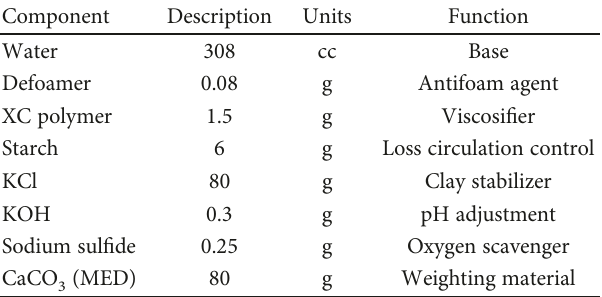
Table 2: Drilling fl uid formulation.